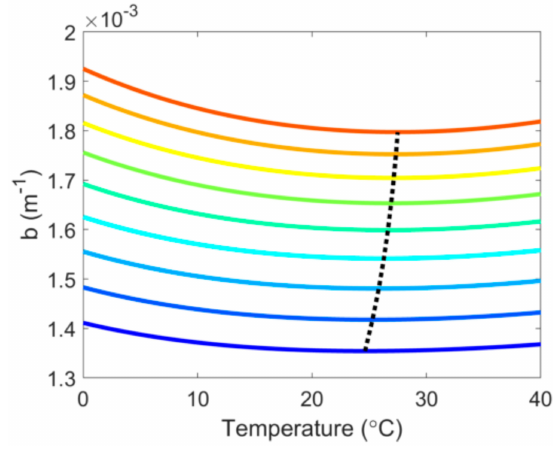
Figure 3. Total scattering coefficient by pure seawater at 546 nm as a function of temperature and salinity. Lines of progressive colors from blue to red correspond to different salinities from 0 to 40 psu at 5 psu increments. The dotted line connects T min at different salinities. Table 1. Temperatures ( T min in ◦ C) at which the scattering of light at 546 nm by pure seawater due to density fluctuations ( b d ), concentration fluctuations ( b c ), and their total ( b ) reach the minimum for various salinities ( S